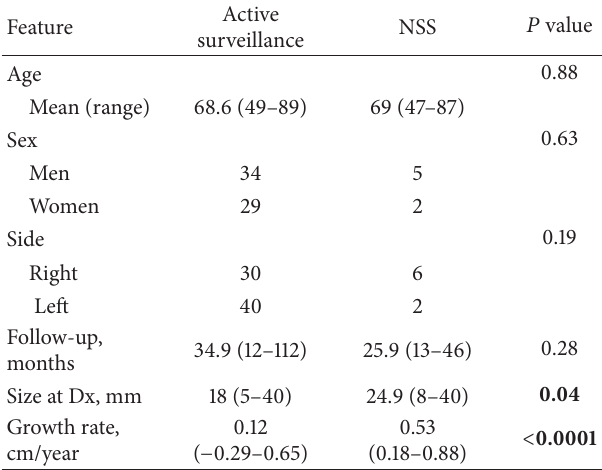
Table 1: Patients and masses characteristics with statistical signifi-